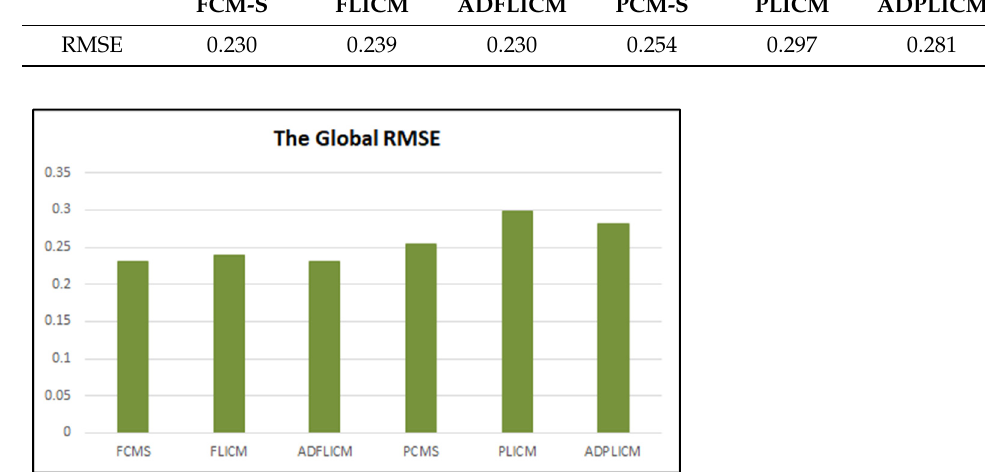
Figure 13. Global RMSE values for fuzzy local spatial information classifier outputs.